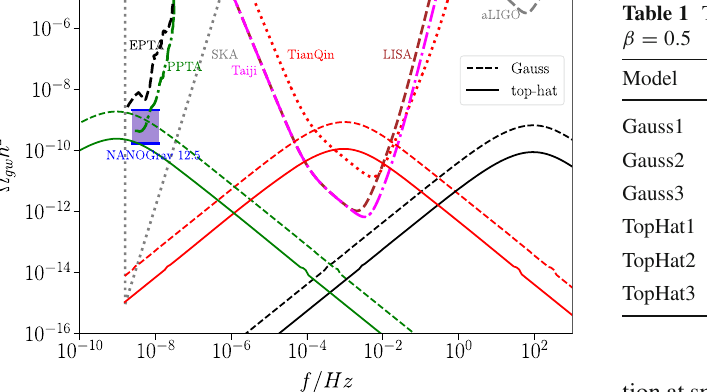
Fig. 3 The convex curves denote the energy density of SIGWs with peak frequencies around 10 − 9 Hz, 10 − 3 Hz, and 10 2 Hz, respectively. The dashed and solid lines are related to the black and red bands in the right panel of Figure 2, respectively. The concave curves represent the GWs detectors limits: the black dashed curve denotes the EPTA limit[106–109,154],thegreendot-dashedcurvedenotesthePPTAlimit [155], the gray dotted curve denotes the SKA limit [110], the red dotted curve in the middle denotes the TianQin limit [114], the magenta dot- dashed curve shows the Taiji limit [113], the brown dashed curve shows the LISA limit [112], and the gray dashed curve in the right denotes the aLIGO limit [156,157]